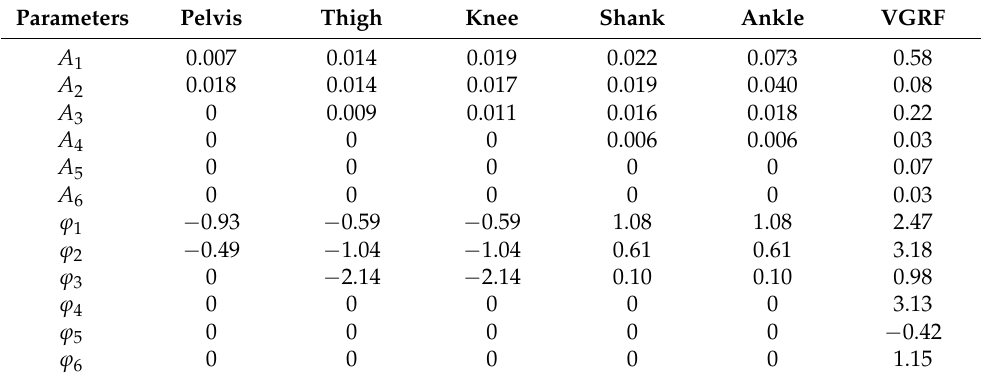
Table 1. The parameters of the vertical displacement of the lower limbs.